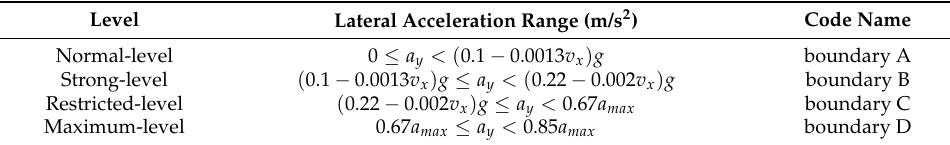
( b ) Figure 11. Experimental equipment framework and road modeling. ( a ) Driving simulation and HIL implementation . ( b ) Hefei- Xuzhou Section of G3 Jingtai Expressway in China in Carmaker. In the HIL experiment, in order to be close to the real road scene, the Hefei-Xuzhou Section of G3 Jingtai Expressway in China is simulated in Carmaker to build a one-way two-lane road with a total length of 700 m shown in Figure 11b. Three different traffic environments are set shown in Figure 12. From the setting of the relationship between the speed and distance of each vehicle, the software indicates that Case Ⅰ represents a kind of